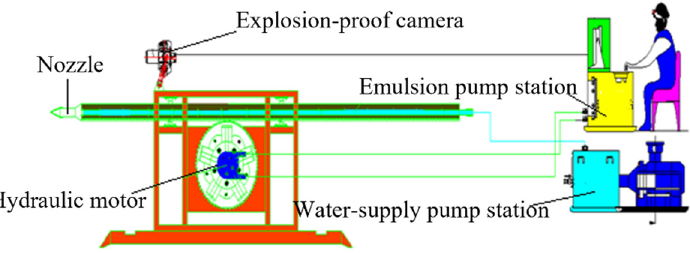
Figure 16. Schematic of the self-developed equipment of high-pressure water jet.